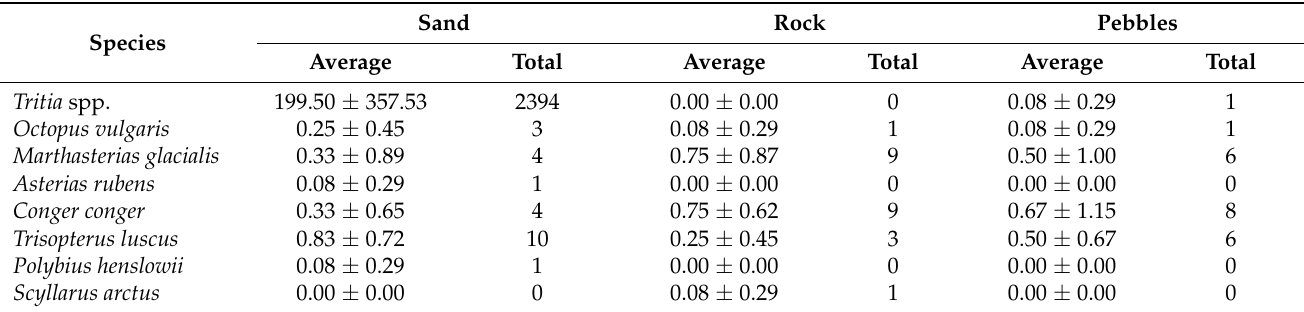
Table 1. Summary of the number of individuals of each megafaunal species per habitat. Average and standard deviation per trap and the total number of individuals captured.